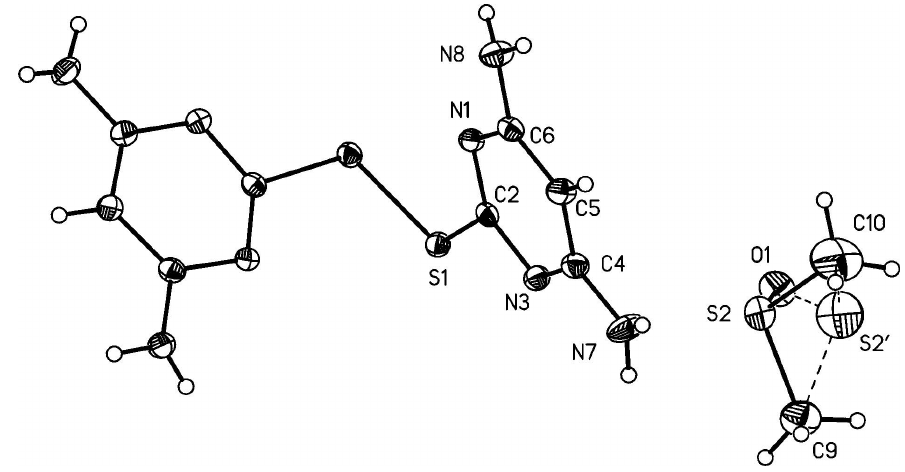
Figure 1 The molecular structure of (I) with displacement ellipsoids shown at the 50% probability level. Bonds of the DMSO molecule in the minor orientation are shown as dashed lines. The unlabelled atoms of the disulfide molecule are generated by the symmetry operation (3/2-x, 1/2-y,